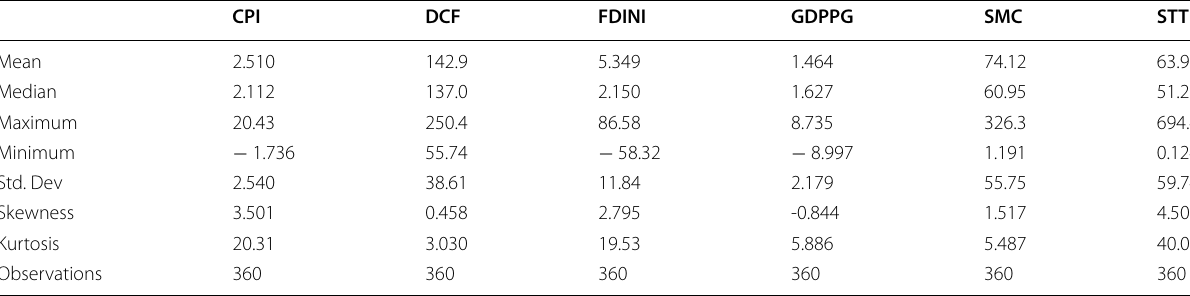
Table 1 Descriptive statistics. Source: Software of E-views 10